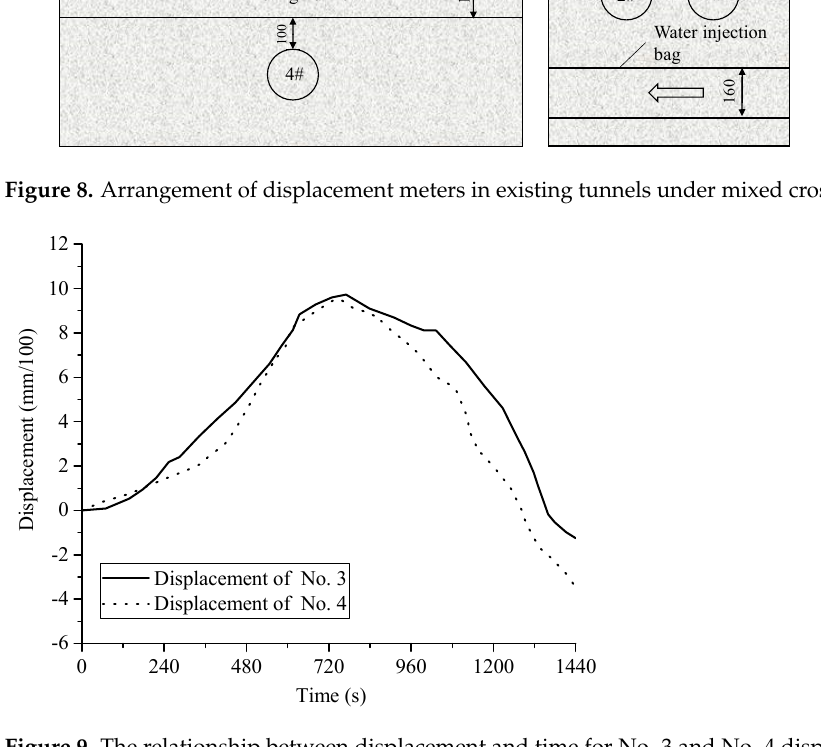
Figure 9. The relationship between displacement and time for No. 3 and No. 4 displacement meters, under the condition of first-up and then-down crossing.